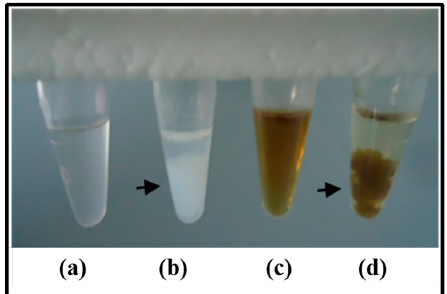
Figure 3. Zn-induced precipitation. ( a , c ) zinc-free human recombinant insulin (5 mg/mL) and Mo -LPI (5 mg/mL) solutions in 0.05 M Tris-HCl, pH 7.5, respectively; ( b , d ) zinc-free human recombinant insulin and Mo -LPI solutions after the addition of 1 M zinc chloride, respectively. Arrows indicate the protein precipitate.